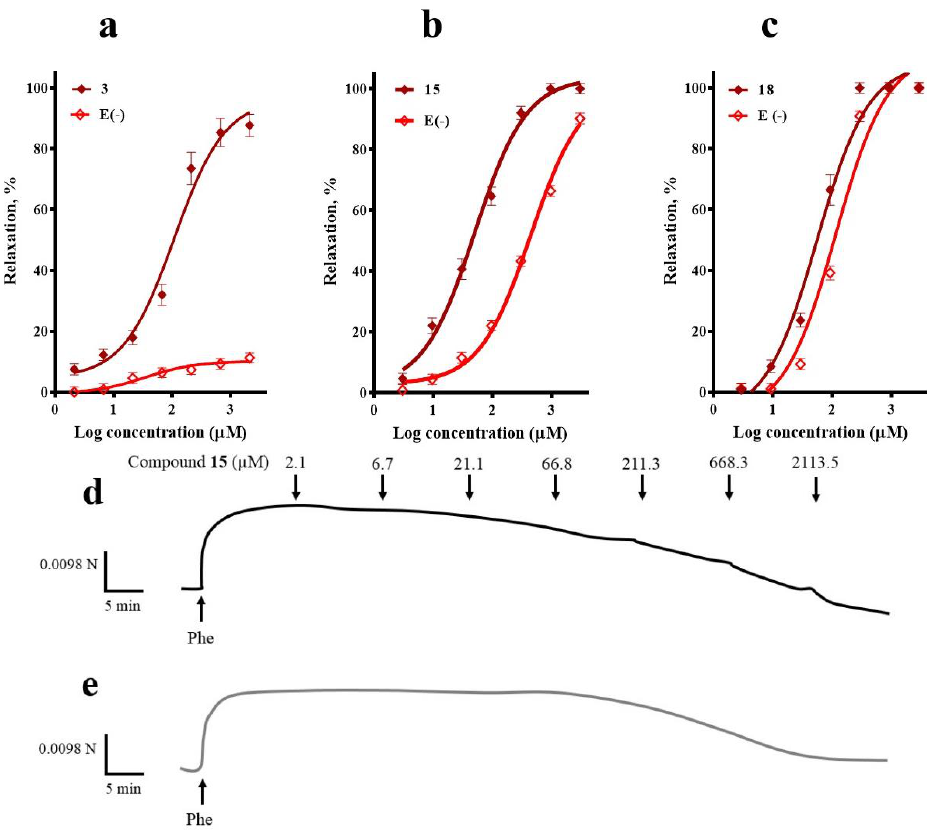
Figure 3. Concentration-response curves of the vasodilator effect of ( a ) corosolic acid ( 3 ), ( b ) meso -dihydroguaiaretic acid ( 15 ), and ( c ) 5,8,4′-trihydroxy-3,7-dimethoxyflavone ( 18 ) in the presence and absence (E-) of endothelium. A typical trace in which meso -dihydroguaiaretic acid ( 15 ) inhibited Phe-induced contraction in endothelium-intact ( d ), and -denuded aorta ( e ). Analysis by an unpaired t -test was made to test for differences between EC 50 s of each compound in the presence and absence of endothelium ( 3 , p < 0.0001; 15 , p < 0.0001; 18 , p = 0.0093).